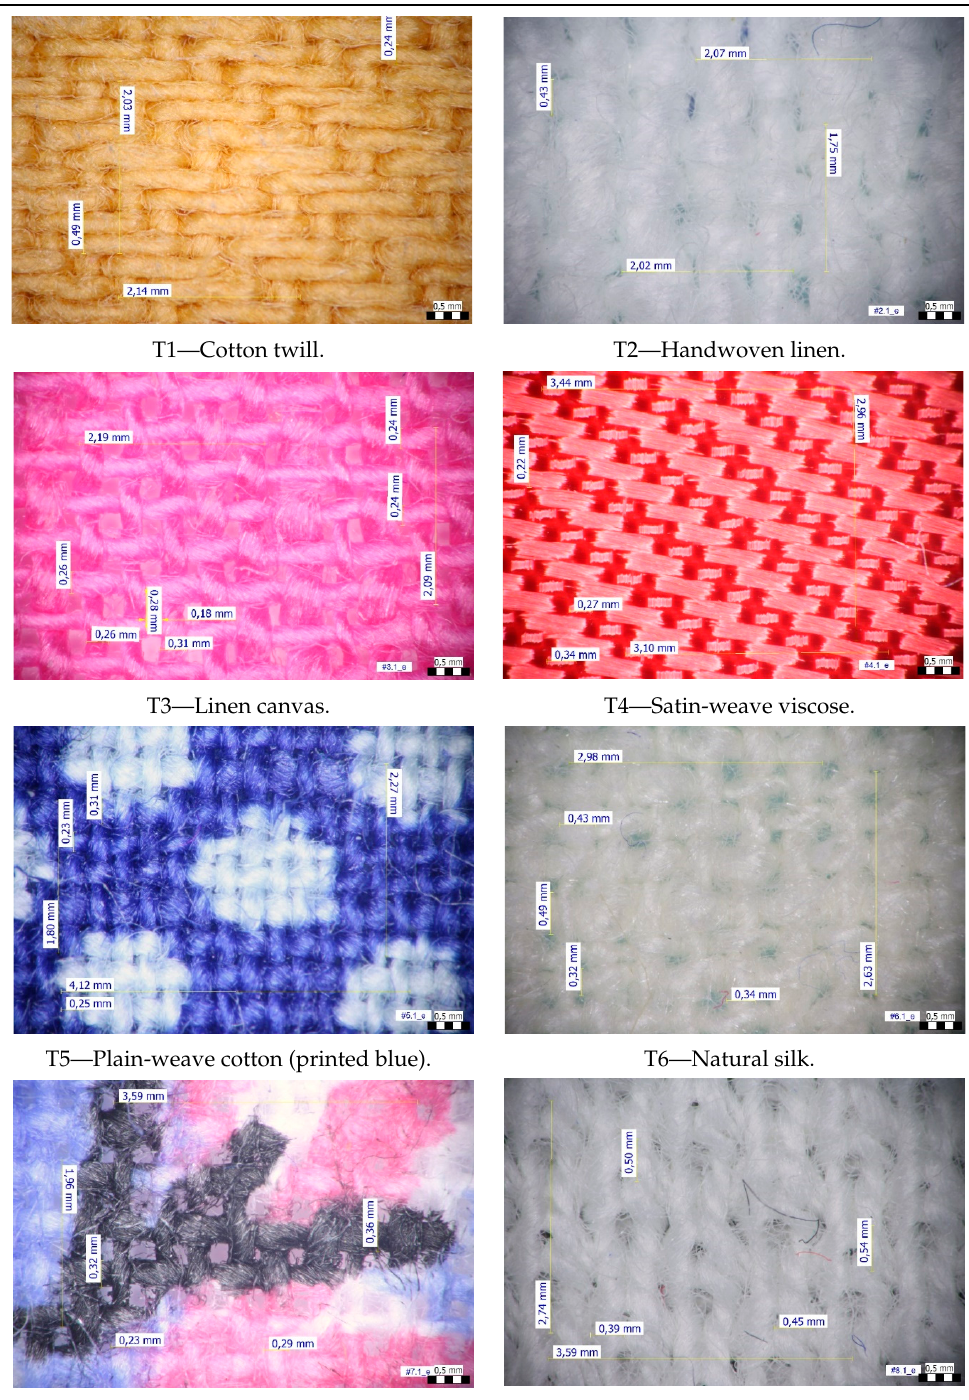
Table 2. Optical inspection of different textile samples.